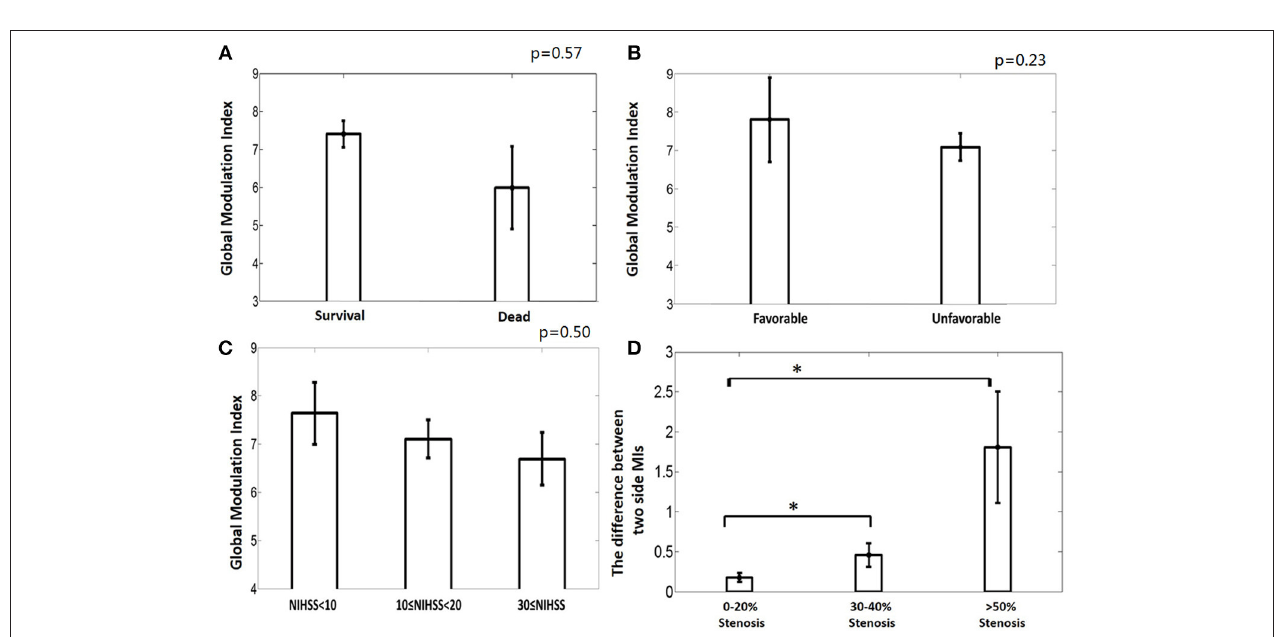
FIGURE 5 | (A) The deceased group tends to have weaker phase-amplitude coupling (PAC) relationship between CBFV and EEG than the survival group, though not significantly. (B) The unfavorable group tends to have weaker PAC than the favorable group, though not significantly. (C) The group with higher NIHSS has weaker global PAC; (D) Greater degree of occlusion in unilateral main artery, demonstrated by higher degree of stenosis, is associated with greater asymmetry in the coupling relationship between the two brain hemispheres. MI: modulation index, which is used to indicate the strength of PAC. One star means p <